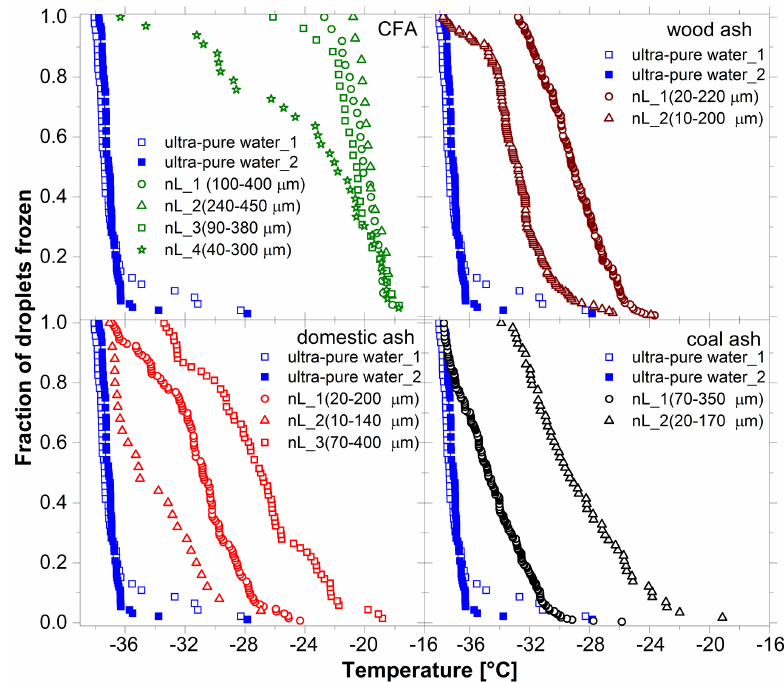
Figure 6. Fraction of droplets frozen ( f ice ) from freezing experiment in the nL-NIPI. Each panel shows freezing curves of droplets containing 0.1wt% of CFA, wood, domestic or coal bottom ashes. The size range of the droplets varied from ∼ 20 to 450µm diameter. We give the range of the droplet diameter, but note that this is a rough guide to the size distribution since the distributions were commonly not log-normal. Most of the experiments in this figure were for droplets in the nano-litre (nL) volume range. For all panels, the royal blue squares (filled and unfilled) represent the freezing curve of ultra-pure water (18.2M (cid:127) cm resistivity) on the same instrumental set-up with droplets ranging from 30 to 400µm diameter for both runs. Uncertainty in the temperature measurements is quoted as ±